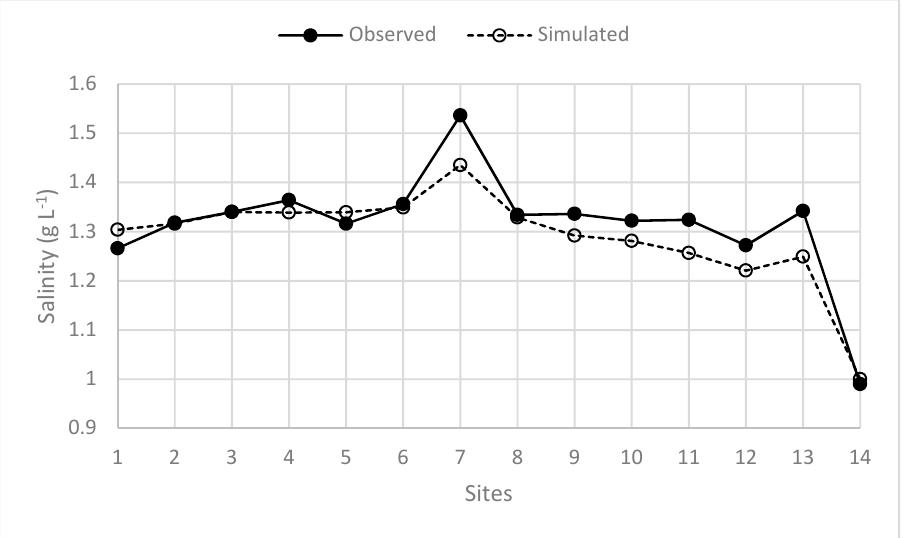
Figure 5. Comparison between observed and modeled salinities at sites 1 to 14 (see Figure 1), where the observed data are marked by filled circles and the simulated results marked by open circles.